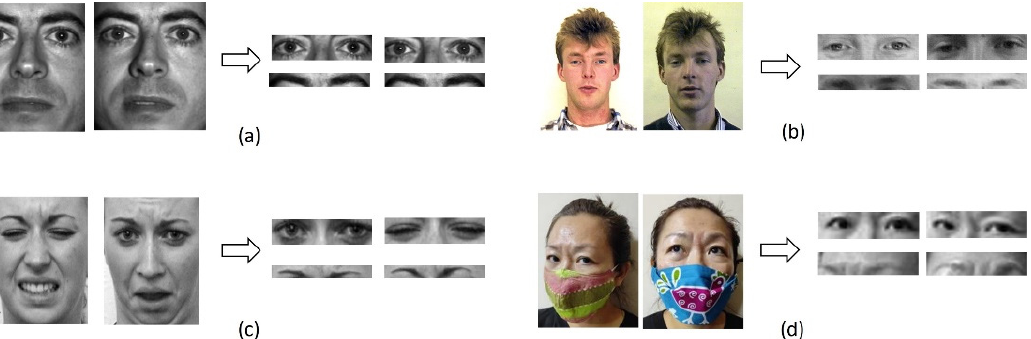
Figure 2. Example of face images from datasets and cropped results for eye and eyebrow images: ( a ) EYB, ( b ) ABD, ( c ) PES, and ( d ) RFFMDS v1.0.